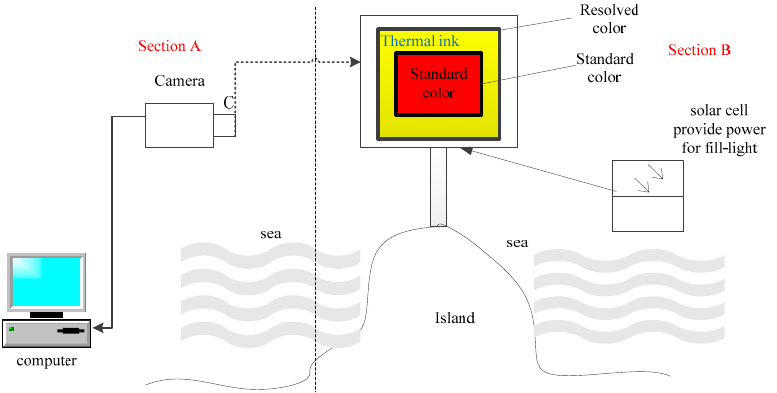
Figure 23. An application of color sensor.